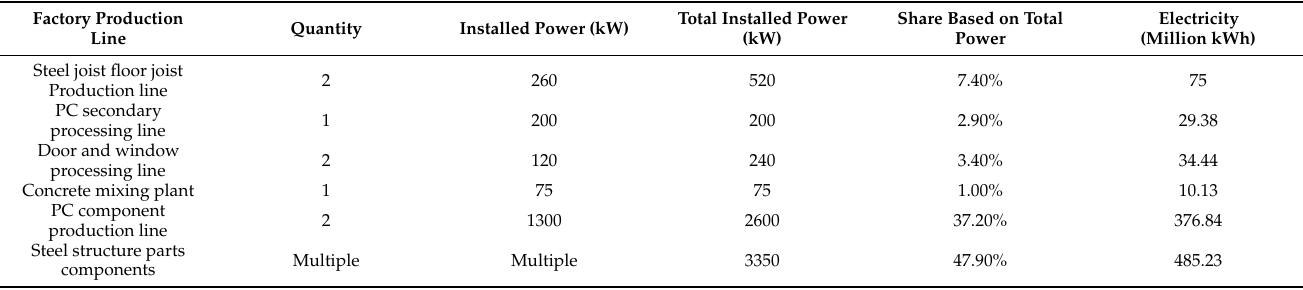
Table 8. Annual power consumption of plant